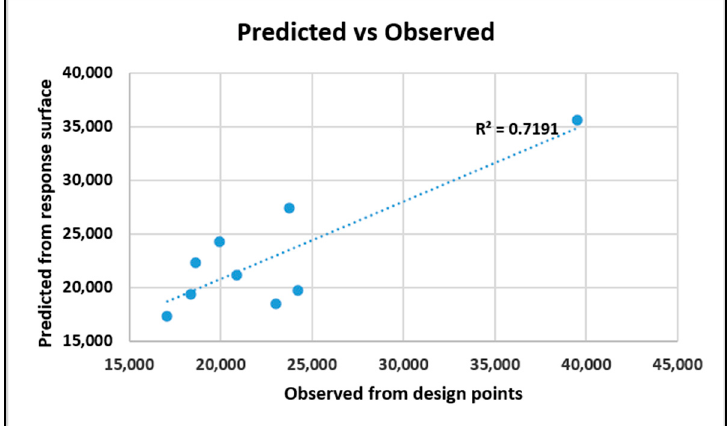
Figure 23. Goodness of fit for the original system from tensile response.